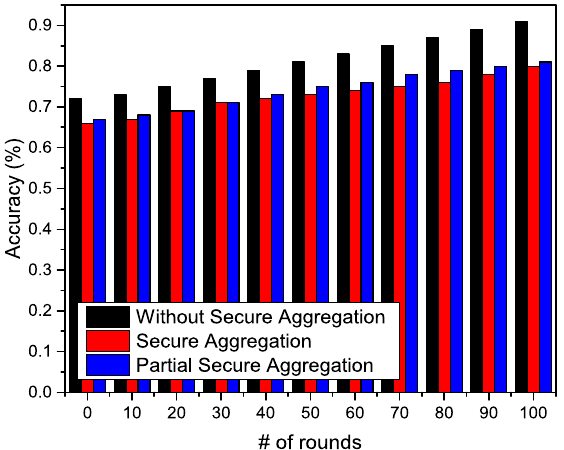
Figure 6. Model aggregation in three different